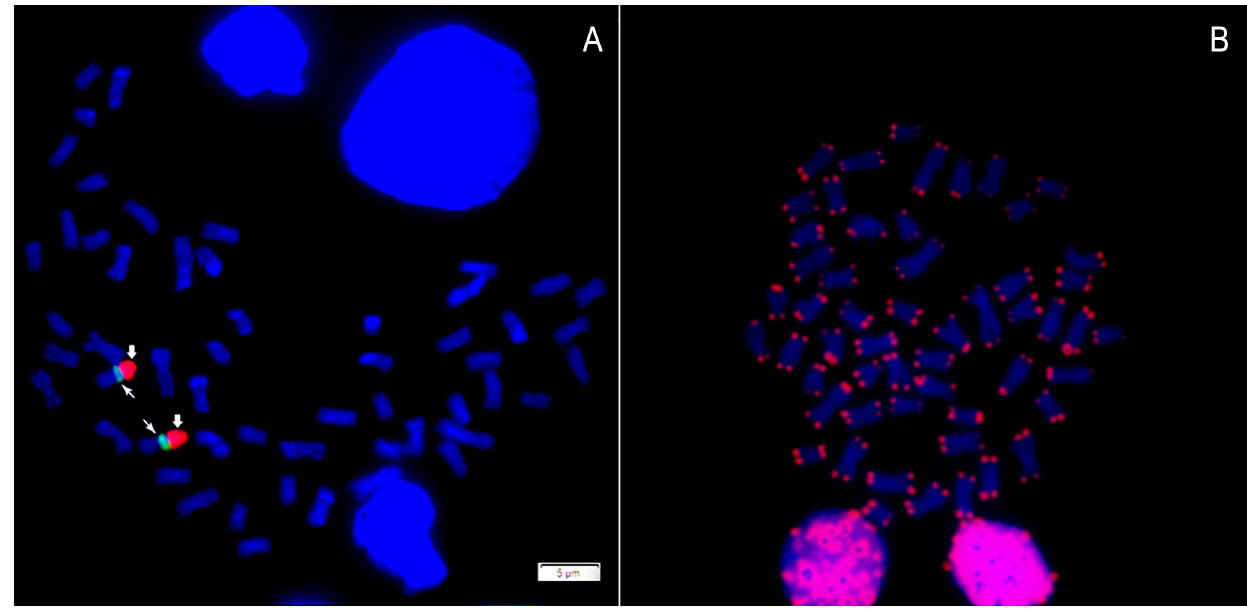
FIGURE 4 | Saccodon wagneri metaphase plates after A . Double FISH with 5S rDNA (green-thin arrows) and 18S rDNA (red-thick arrows) probes; B . FISH using telomeric probes showing positive signals in the terminal positions of all